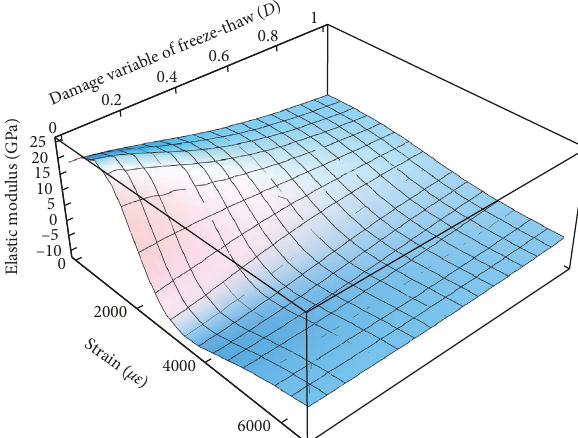
Figure 6: Stress-strain surface with varying freeze-thaw damage variable and elastic modulus surface. Table 3: Quasi-static compression test data and elastic modulus after different numbers of freeze-thaw cycles. Number of freeze-thaw